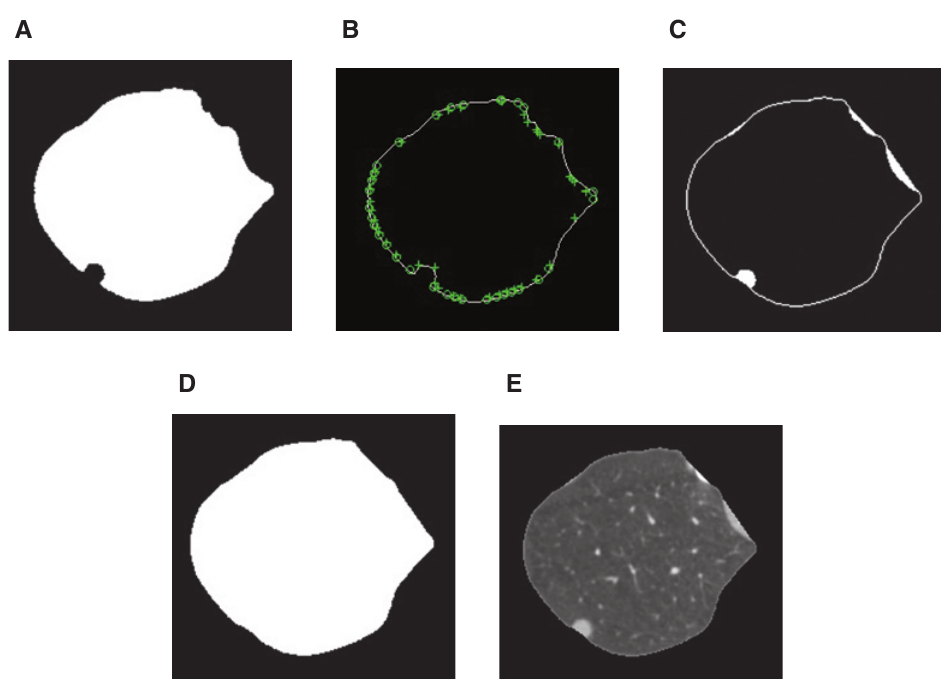
Figure 10: Illustration of Extracted Lung Parenchyma Repairing.